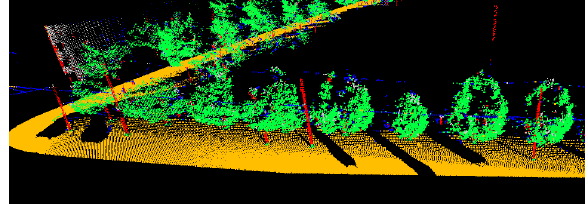
Figure 5: 3D point cloud with semantic labels assigned by the RF classifier (wire: blue, pole/trunk: red, fac¸ade: gray, ground: brown, vegetation: green). Table 7 for QDA-based classification. The respective values for